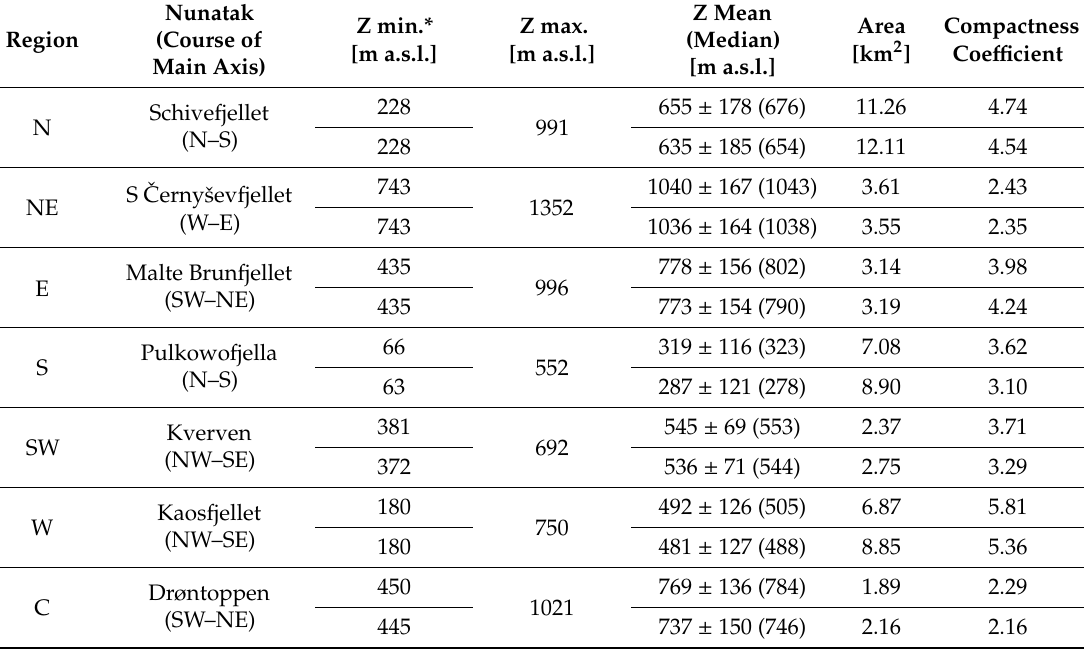
Table 2. Selected nunataks from Spitsbergen and their characteristics.